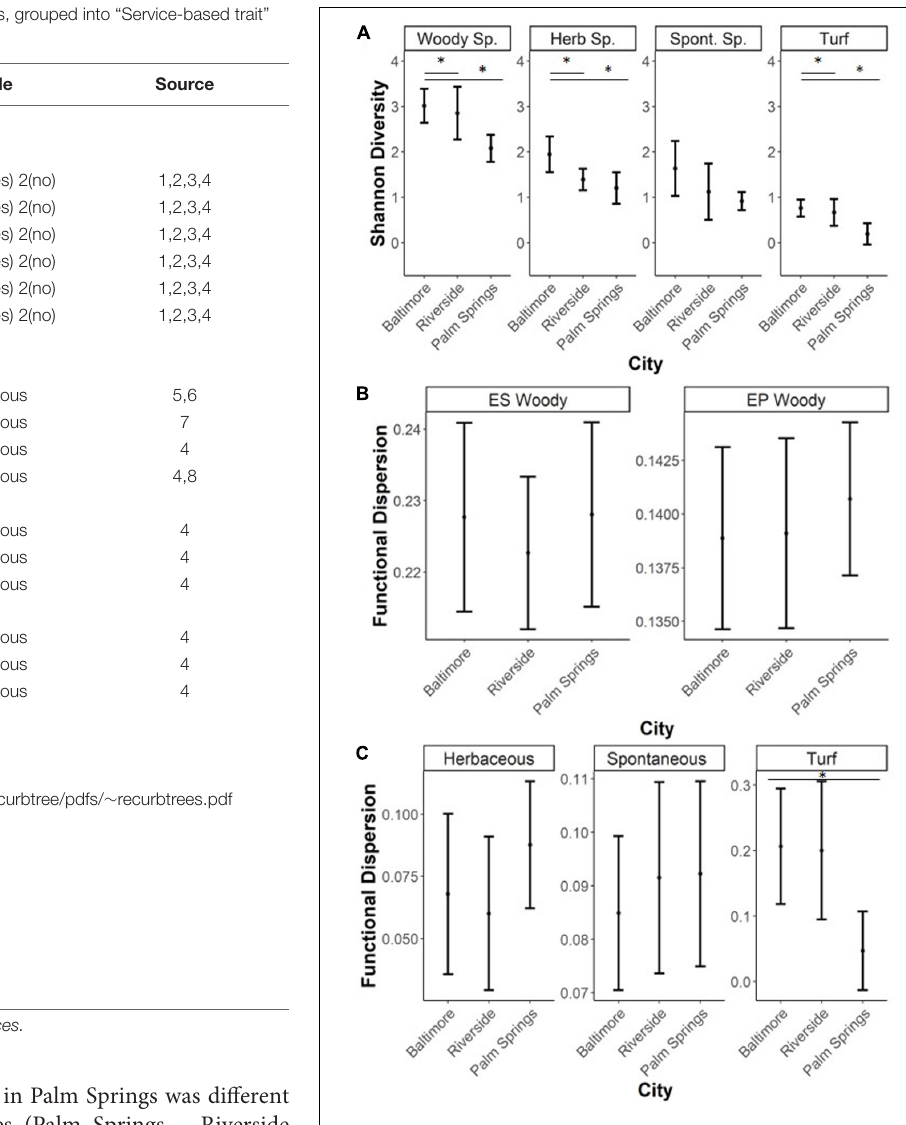
FIGURE 2 | Metrics of alpha diversity for each vegetation type (mean and standard deviation). Asterix refer to significant differences between groups tested through ANOVA with a post hoc Tukey HSD test (*0.001 < p < 0.05). Herbaceous species are both spontaneous and turf species (A) Taxonomi.c alpha diversity was measured by Shannon-Weiner Diversity, (B) Functional alpha diversity (FDis) of woody species, (C) FDis of herbaceous type species. FDis was measured by Functional Dispersion, an abundance weighted metric of functional trait